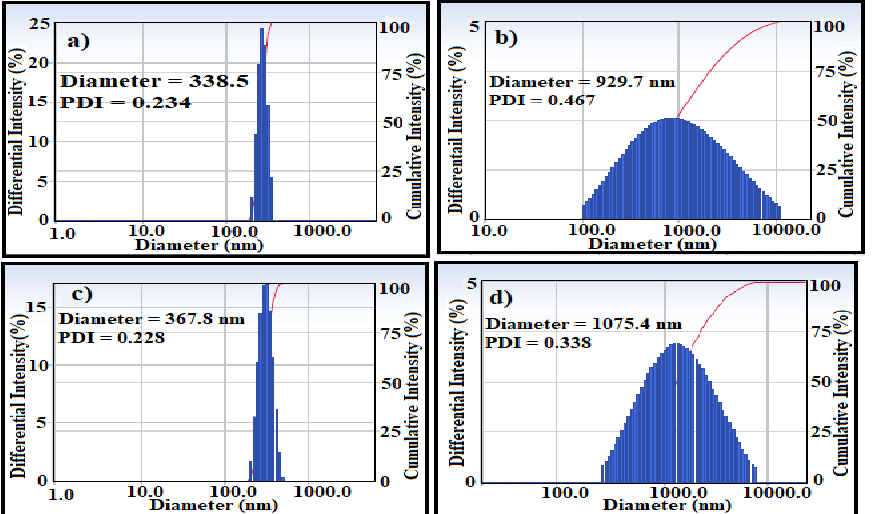
Figure 5. Particle size distribution of magnetite nanomaterials coated by ( a ) M. aurea extract (MAE-MNMs), ( b ) M. aurea extract (MAE-MNMs) after 5 cycles, ( c ) O. baccatus extract (OBE-MNMs), and ( d ) O. baccatus extract (OBE-MNMs) after 5 cycles in ethanol solvent.